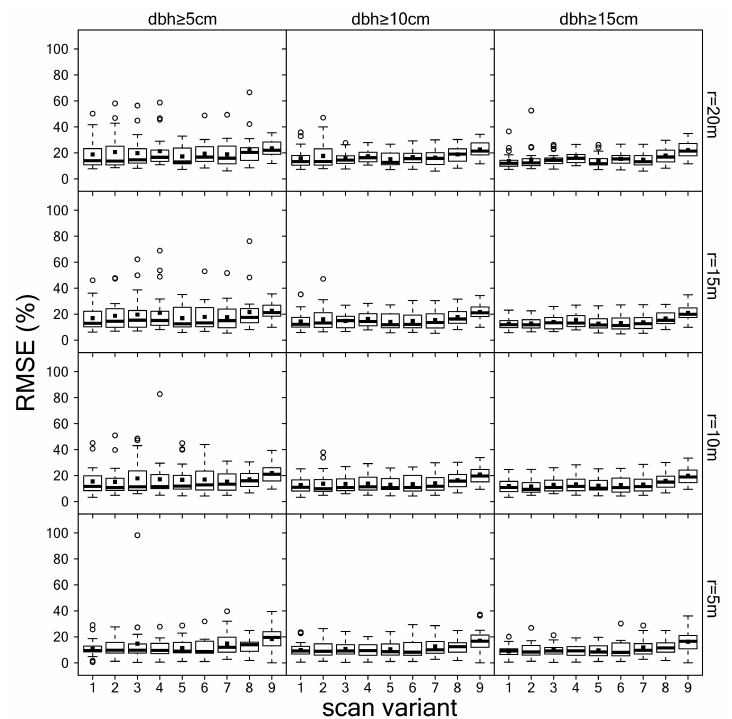
Figure A2. dbh RMSE in % for di ff erent scan variants, lower dbh thresholds, and plot radii. Black squares represent mean dbh